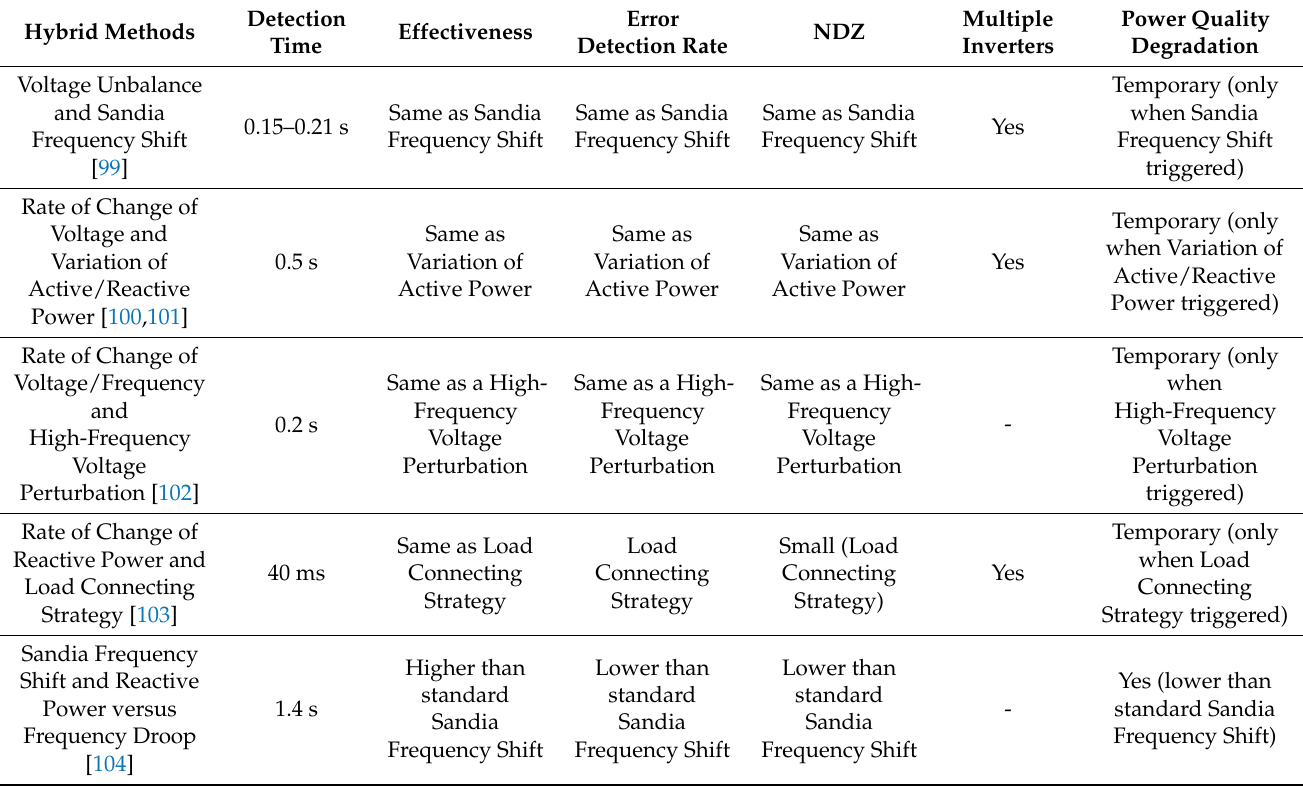
Table 3. Resume of the hybrid islanding methods presented in this document.